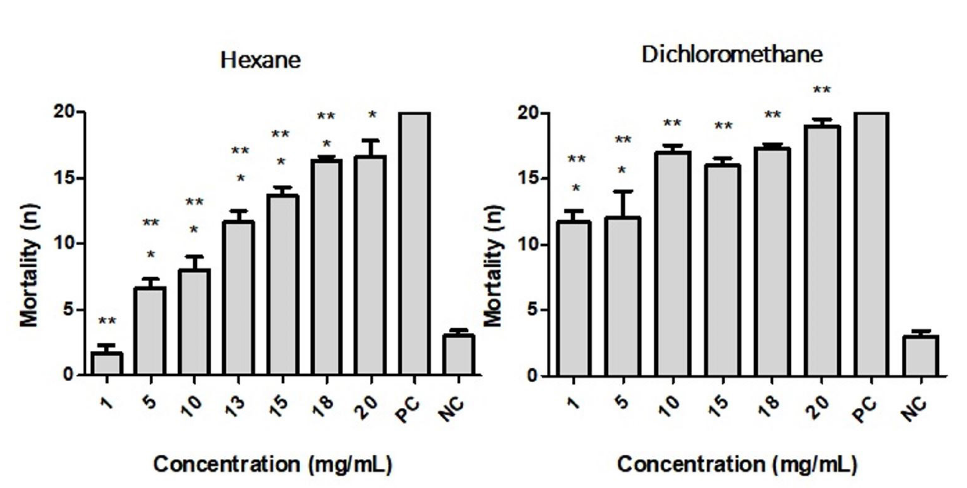
Figure 4. Dose-response curve of mortality (n) of Aedes aegypti pupae versus concentrations (mg/mL) of fractions of Helicteres velutina after 72 hours. The LC 50 and LC90 were calculated using non-linear regression, considering a 95% significance level. (*) Results significantly different from negative control. (**) Results significantly different from positive control.